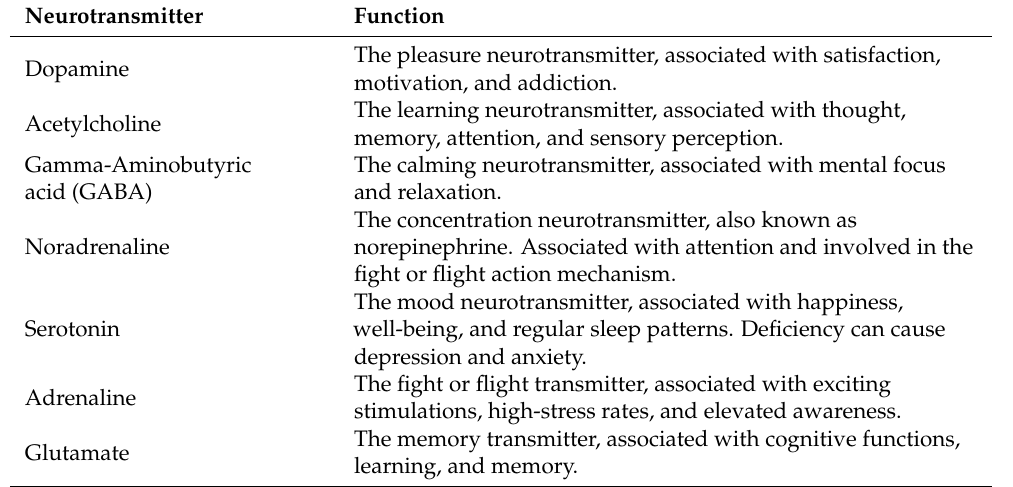
Table 1. List of common neurotransmitters and their functions